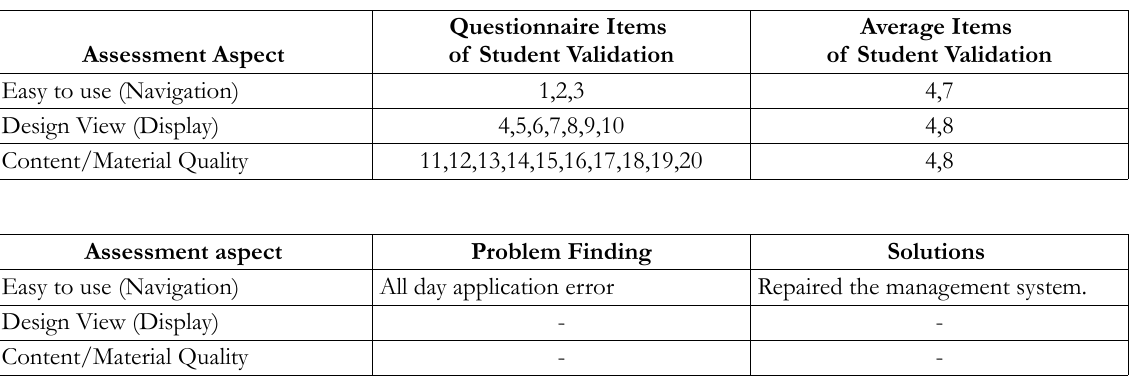
Table 8. Results of Field Try-out